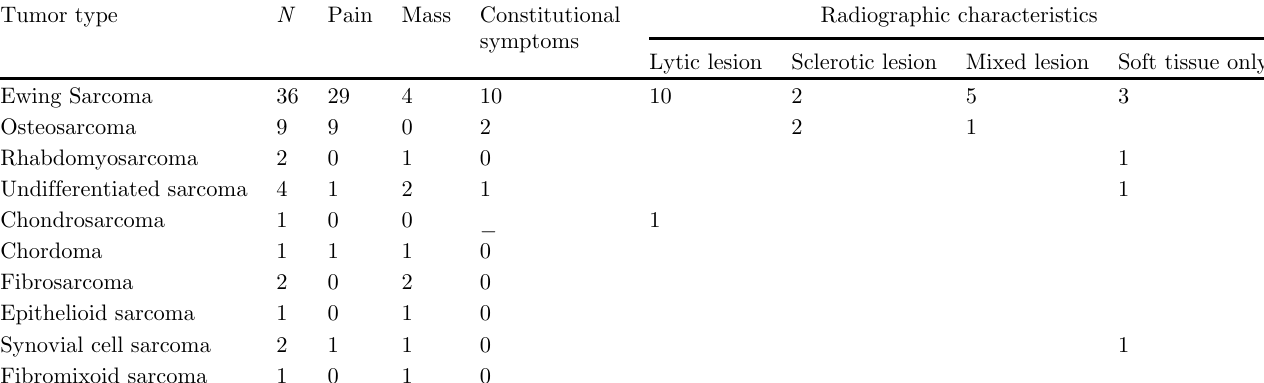
Table 2. Clinical and radiographic presentation strati fi ed by sarcoma type.